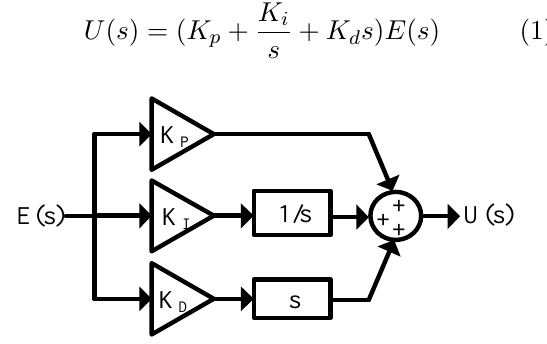
Figure 1. Block diagram of a PID